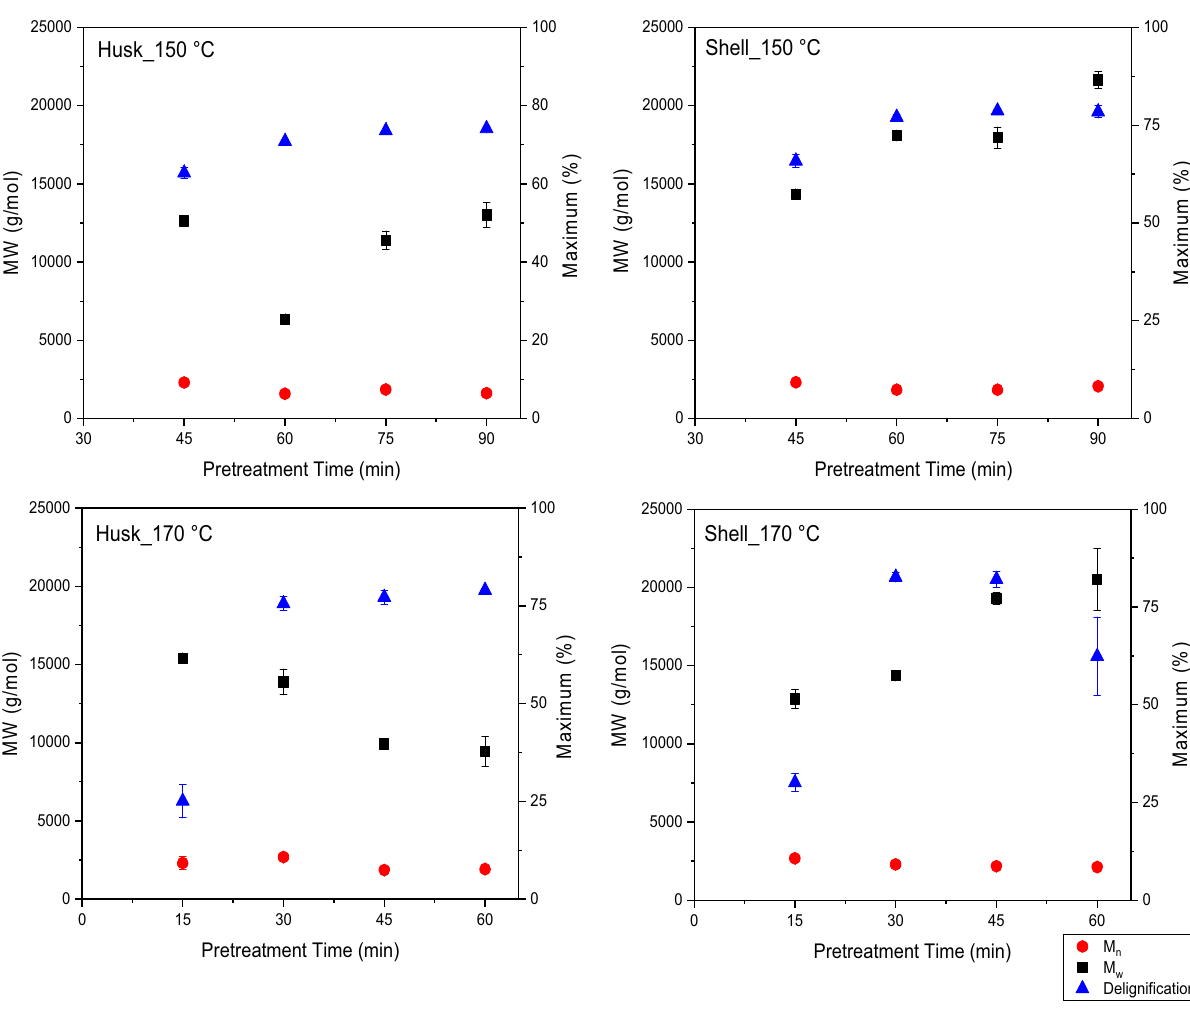
Figure 5. Relationship between biomass delignification and molecular weight distribution for lignins isolated from the IonoSolv pretreatment of 1:10 g/g biomass (husk and shell) and [DMBA][HSO 4 ] with 20 % water at 150 °C for 30–90 min and 170 °C for 15–60 min (Error bars represent standard deviations for two replicate